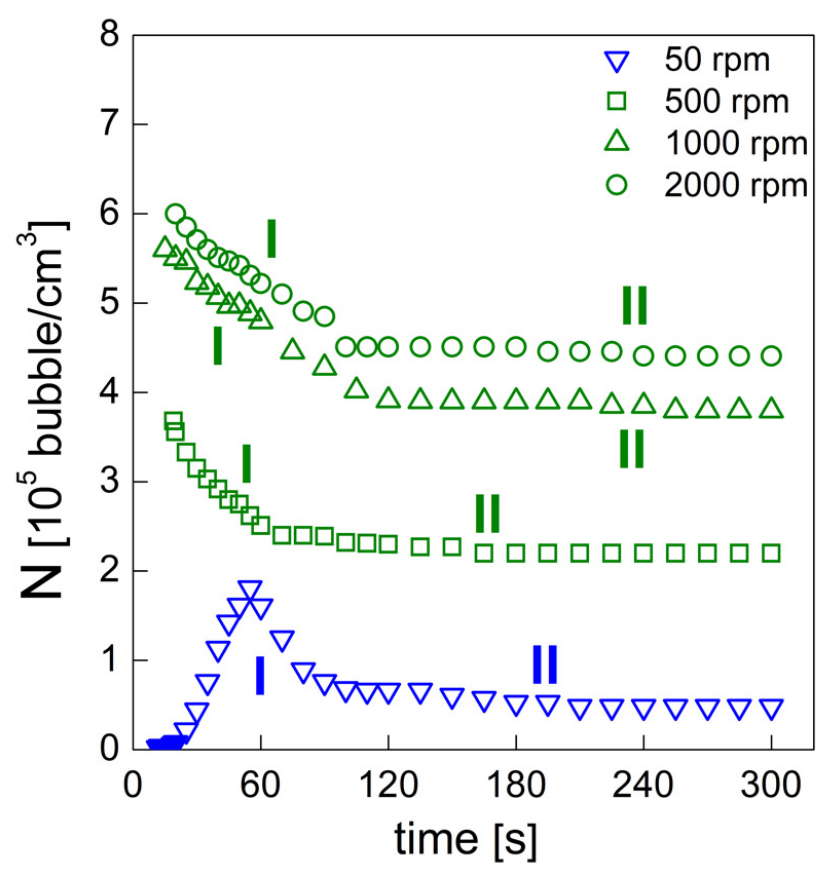
Figure 5. Bubble density evolution of the PU foams obtained at different mixing speeds. Table 2. Results of the fitting procedure.